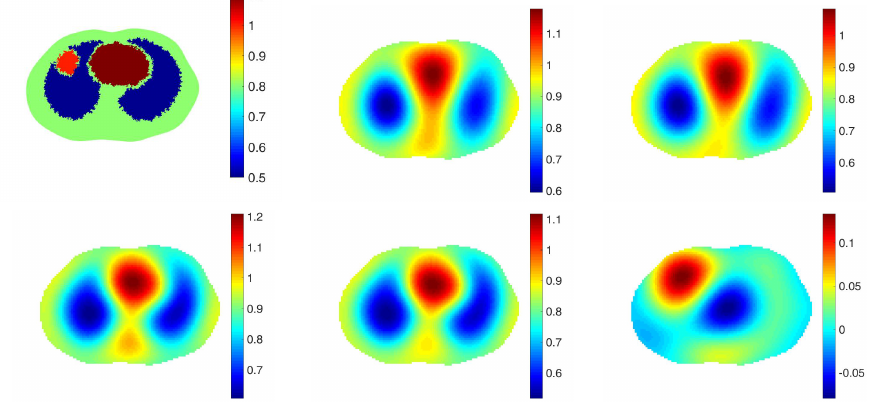
Figure 5. Simulated pulmonary contusion. From left: The true conductivity distribution, reconstruc- tion of γ abs with no prior, γ diff with no prior, γ abs pr with the spatial prior, γ diff pr with the spatial prior, a difference image in which the data for the example of healthy heart and lungs in Figure 2 with no pathology is chosen for γ ref . The L2 norms of the differences between those reconstructions and the ground truth are 0.2958, 0.3071, 0.2927 and 0.3040 in